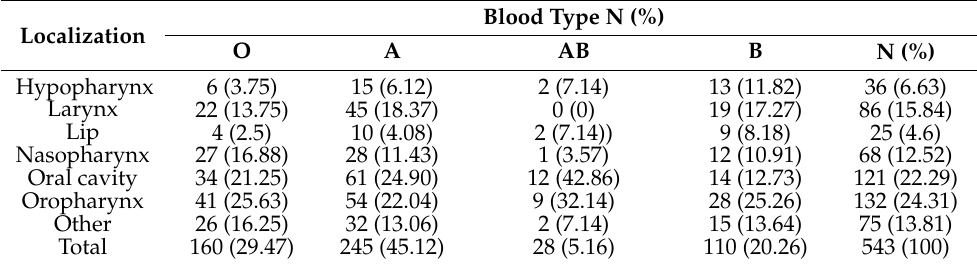
Table 1. Contingency table for H&N cancer localization with blood group.